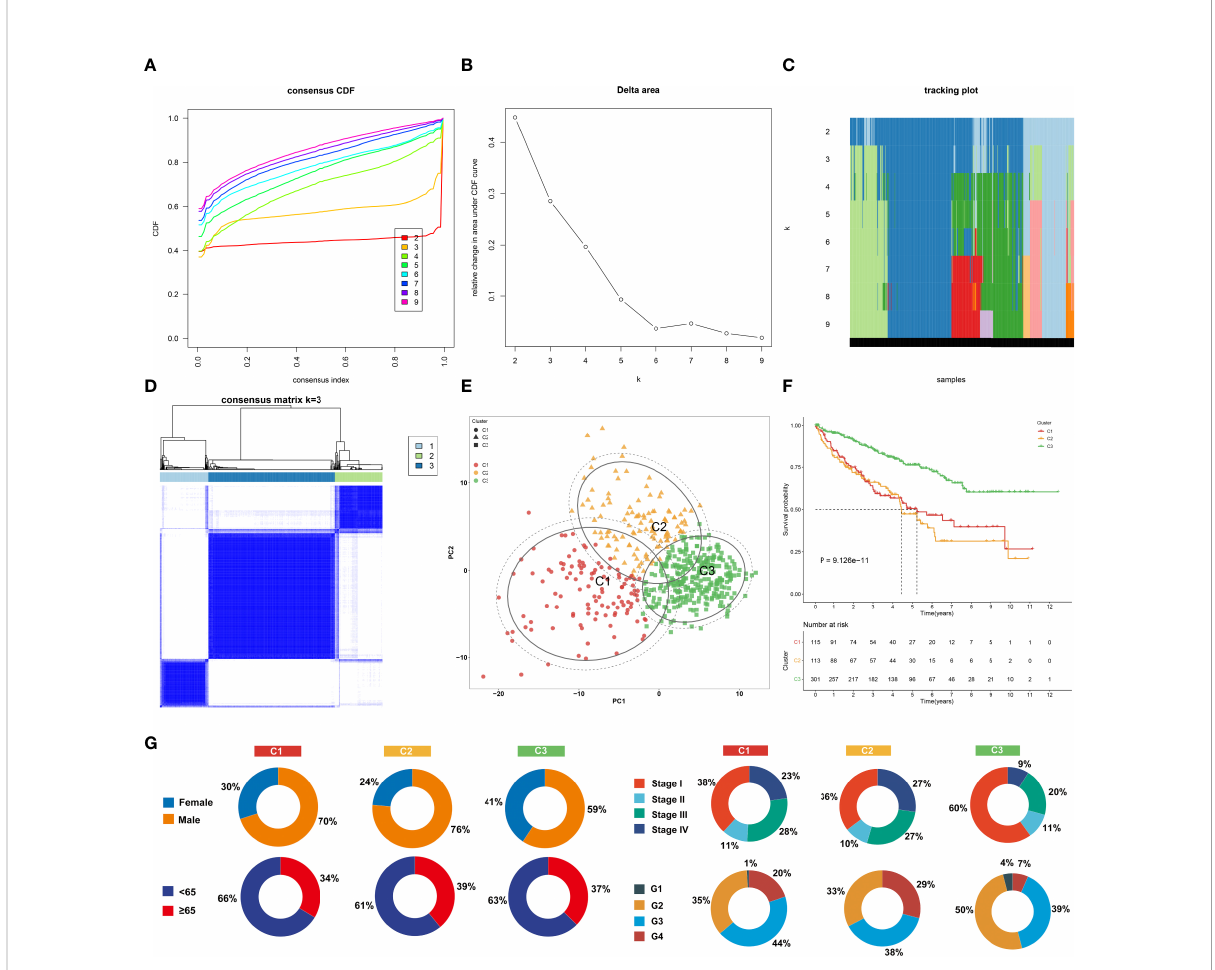
FIGURE 2 The landscape of prognosis and clinical features of the three aging phenotypes in The Cancer Genome Atlas-kidney renal clear cell carcinoma (TCGA-KIRC) cohort. (A) The cumulative distribution functions (CDFs) of the consensus matrix for k = 2~9 marked by colors. (B) Relative alterations in area under the CDFs for k = 2~9. (C) Tracking plot for the classi fi cation of the TCGA-KIRC dataset into diverse subtypes for k = 2~9. (D) Classi fi cation of the TCGA-KIRC cohort into three clusters when k = 3. (E) PCA of the RNA expression pro fi ling of prognostic aging- associated genes. (F) Kaplan – Meier analysis for overall analysis (OS) among the three phenotypes. (G) Pie plots of the distribution of clinical features across the three